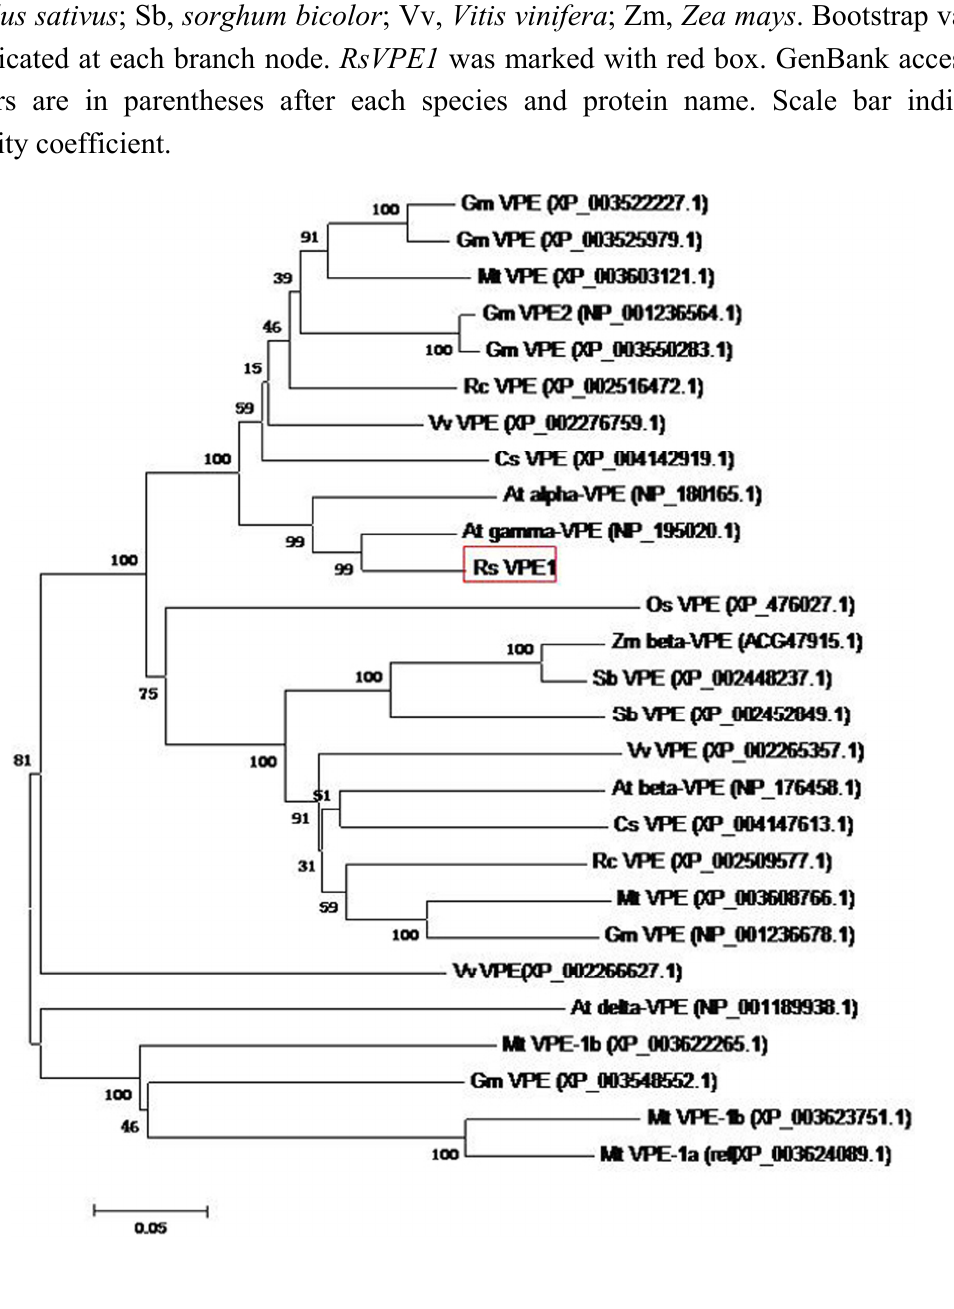
Figure 4. Phylogenic tree of VPE proteins. The rooted gene tree (majority-rule consensus from 1000 bootstrap replicates) resulted from heuristic searching in Mega5.0.